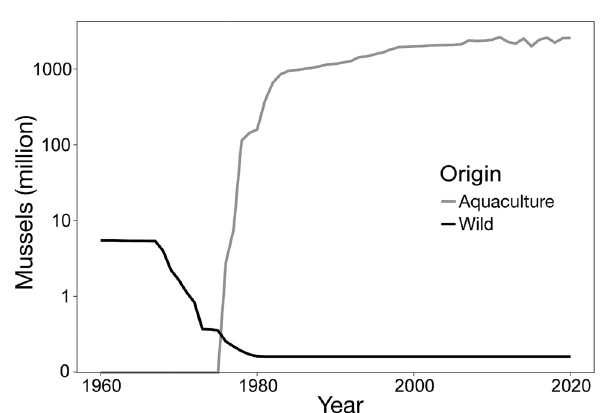
Fig. 2. Estimated mussel populations over time in the Marl- borough Sounds, New Zealand. The grey line indicates the estimated total number of mussels at aquaculture sites, and the black line shows estimates of the numbers of wild mussels on the seabed or shoreline (T. A. Toone unpubl. data). Note that the y -axis uses a log scale to account for the